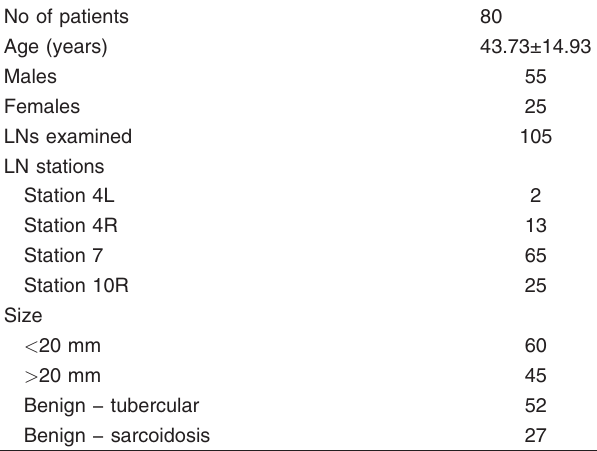
Table 2 Elastographic patterns and colors compared with final pathologic diagnosis Elastography